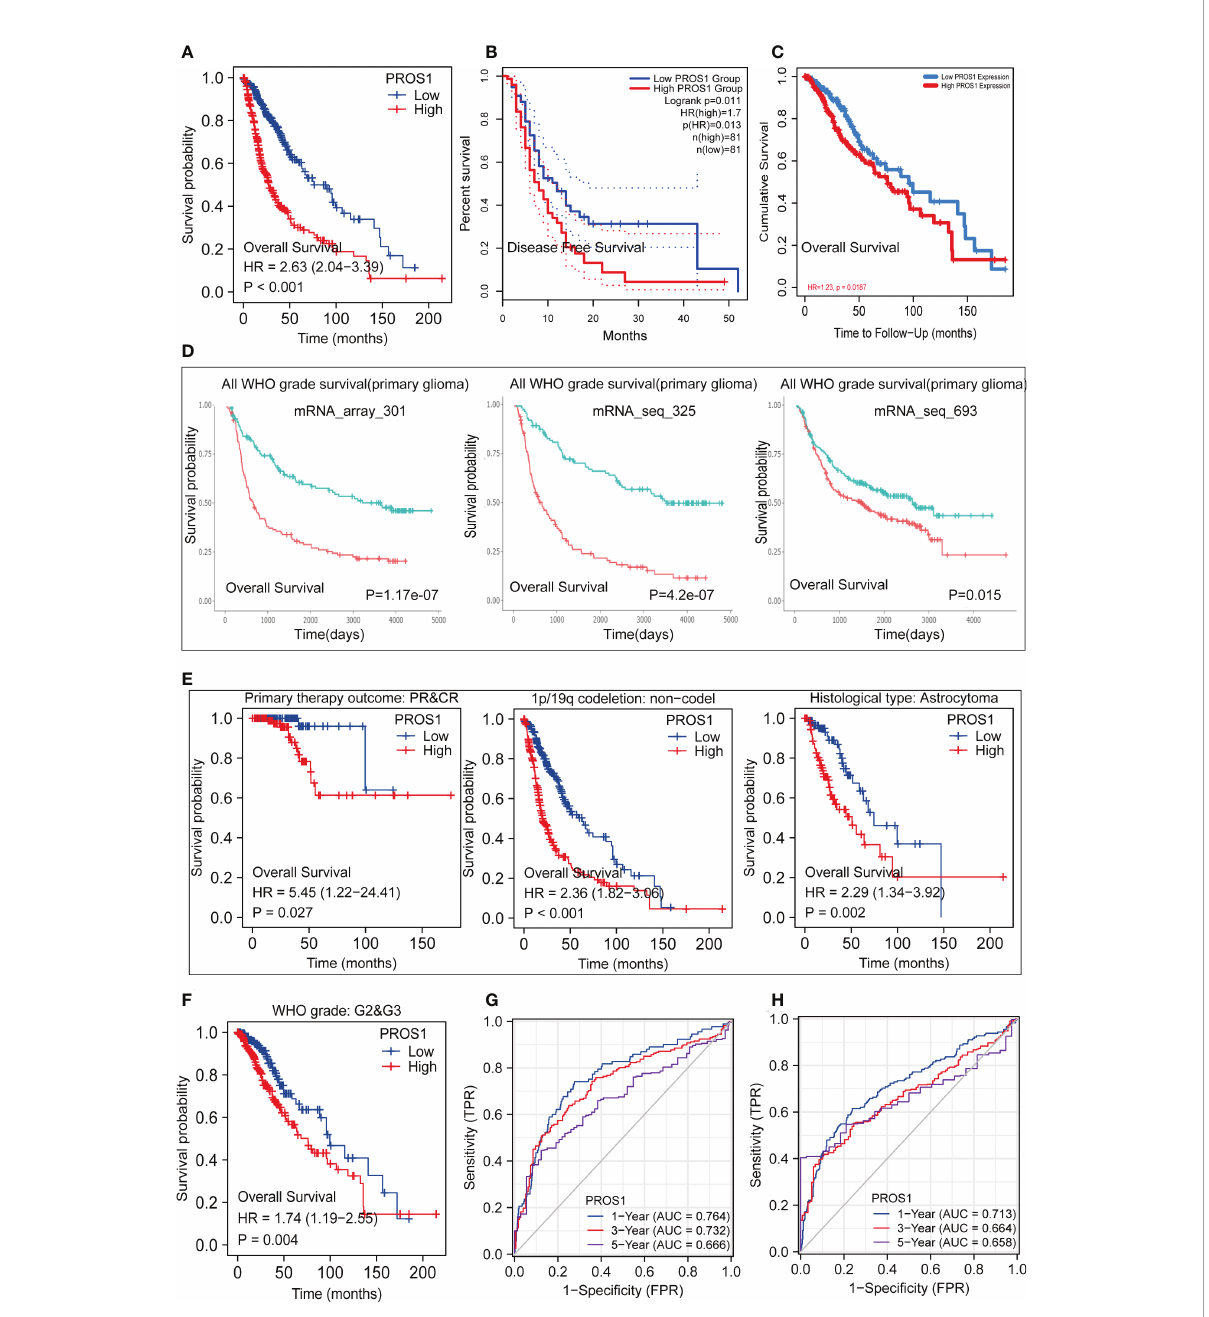
FIGURE 8 Kaplan-Meier survival and Receiver operating characteristic (ROC) curves. Kaplan-Meier survival analysis forglioma patients between PROS1-high and -low group in TCGA (A) , GEPIA2.0 (B) , TIMER2.0 (C) , CGGA (D) . (E, F) Subgroups Kaplan-Meier survival analysis of high and low PROS1 expression in PR&CR, 1p/19q codeletion, histological type, and G2&G3 glioma patients. (G, H) 1-, 3- and 5-year OS and PFI ROC curves based on risk score in